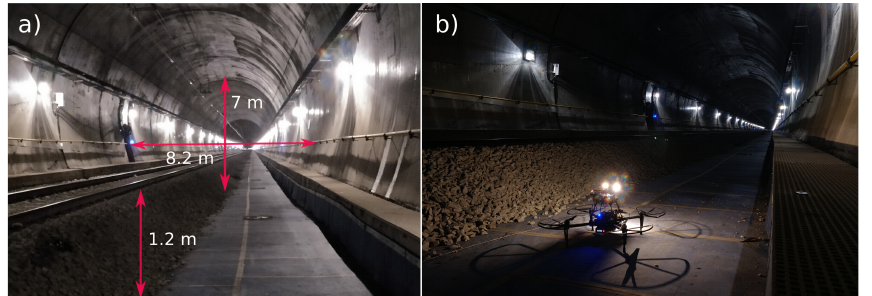
Figure 9. Single track railway tunnel used for the real experiments: ( a ) Tunnel central height, width and rail tracks height representation. ( b ) Aerial platform with the on-board illumination